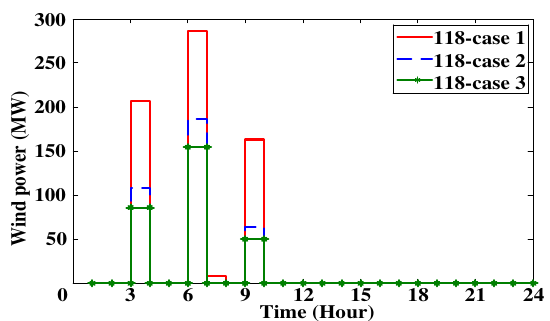
Fig. 13 Comparisons of the wind curtailment of IEEE 118-bus